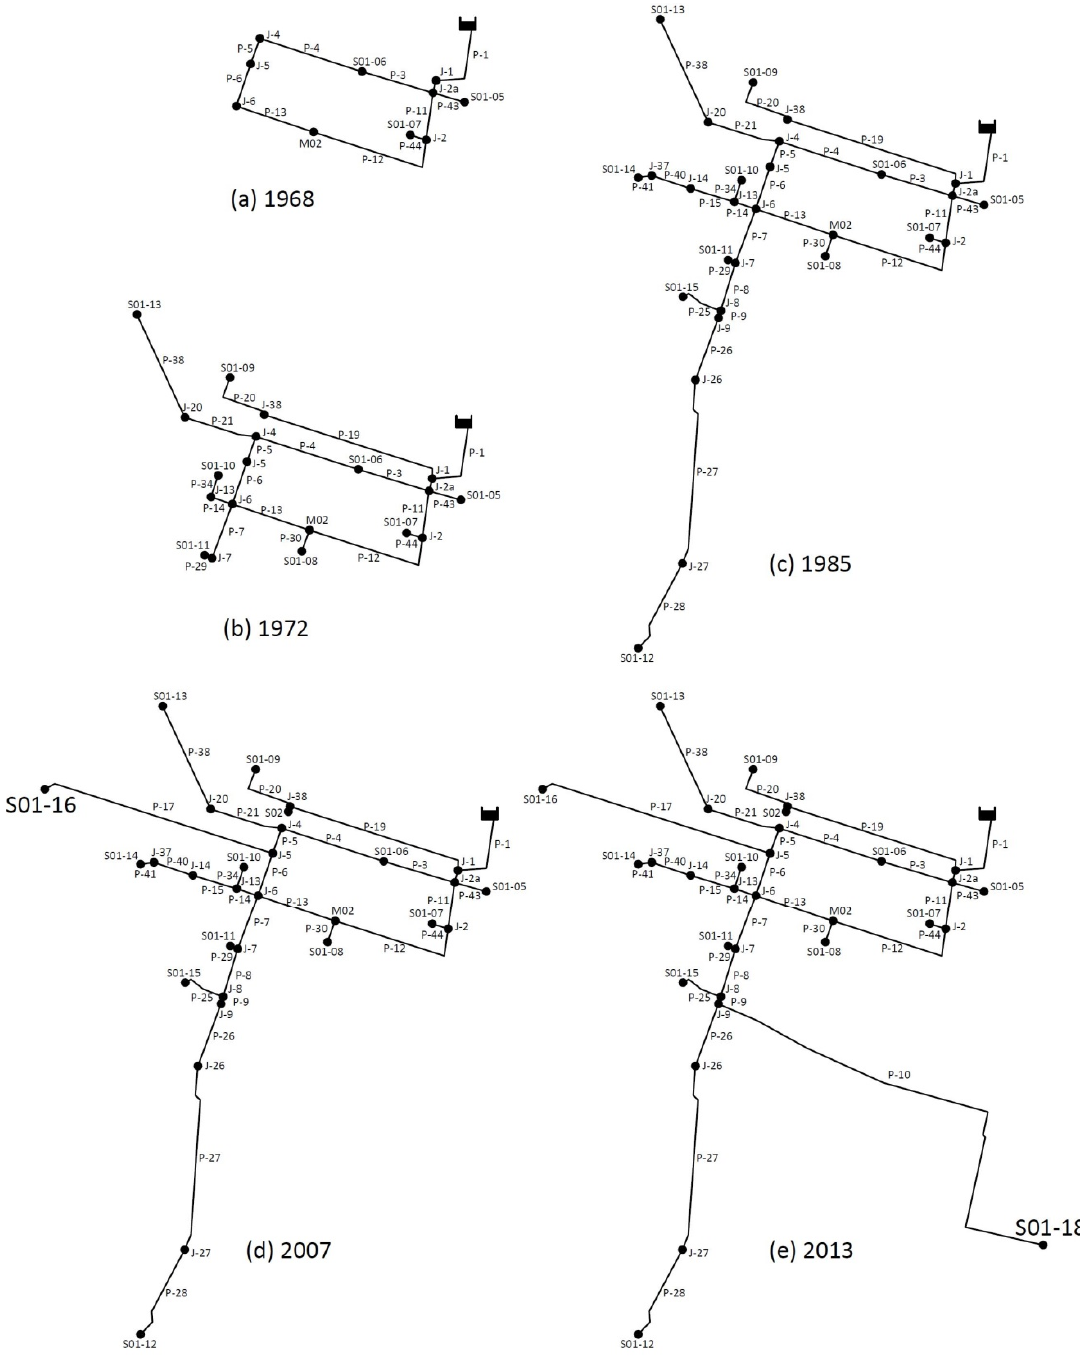
Figure 7. Growth of the Oruro southern subsystem network.